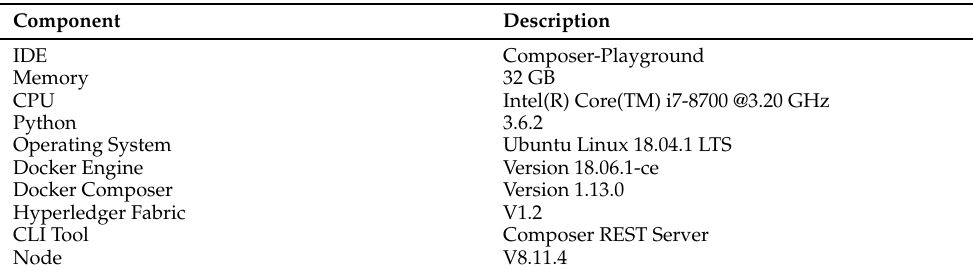
Table 3. Development environment of the proposed system.